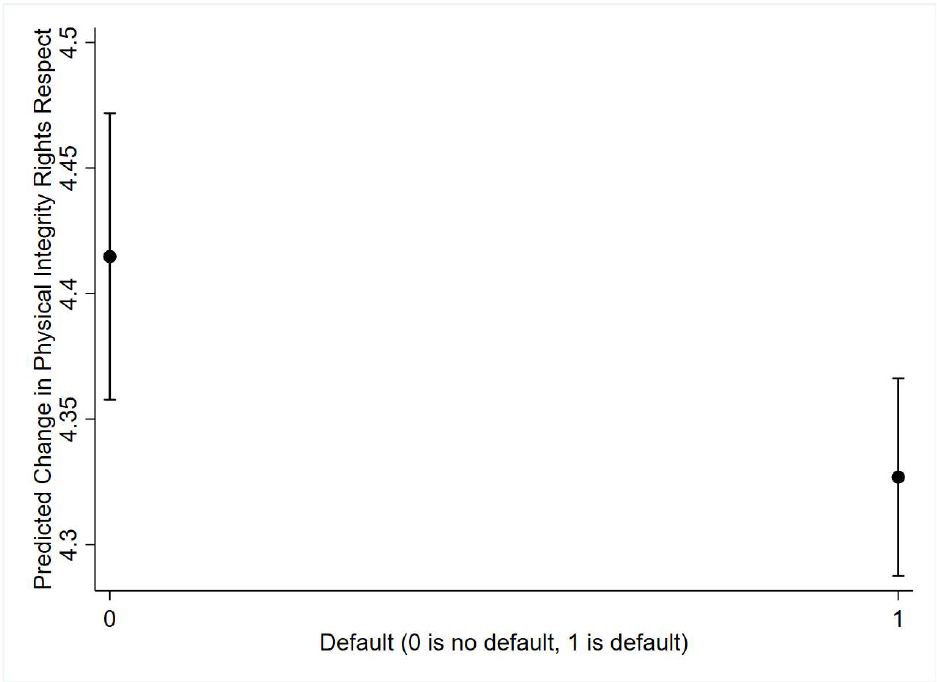
Figure 1. Marginal Effects of Default on Respect for Physical Integrity Rights (95% CIs).